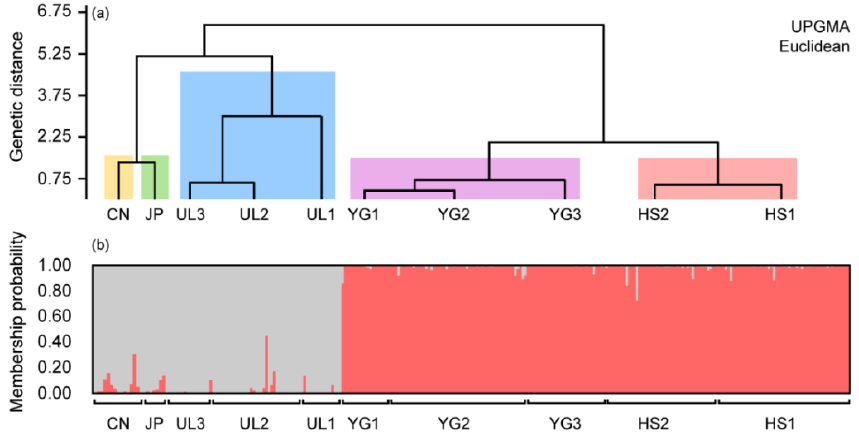
Figure 5. Population clustering by genetic distance and Bayesian clustering algorithms. ( a ) Tree obtained by unweighted pair group method with arithmetic mean (Euclidean algorithm) among the spring orchids from Yeonggwang-gun (YG), Ulleung Island (UL), Heuksan Island (HS), China (CH), and Japan (JP). ( b ) Two main split clusters obtained by STRUCTURE analysis among the spring orchids from the five sites.